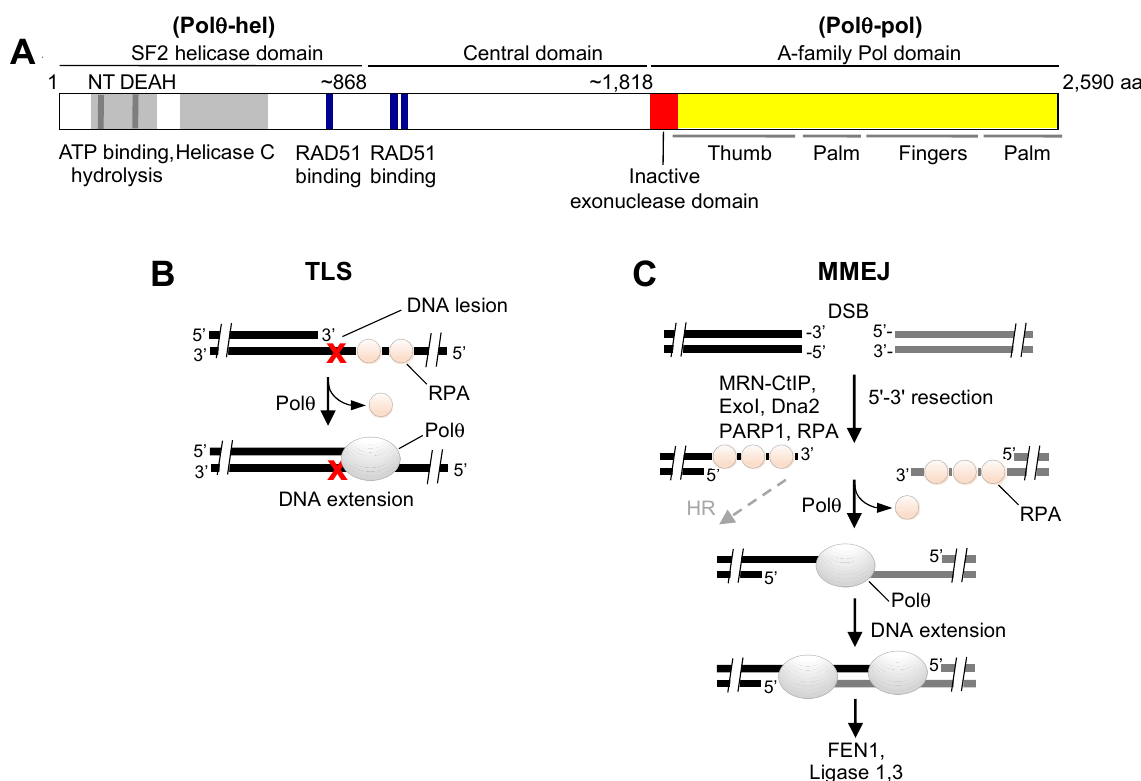
Figure 1. Overview of Pol θ structure and function in DNA repair. ( A ) Schematic of full-length Pol θ . ( B ) Pol θ performs TLS enabling cellular tolerance to DNA damaging agents, such as ultraviolet light. ( C ) Pol θ promotes MMEJ, which results in the error-prone repair of DSBs and resistance to ionizing radiation and topoisomerase inhibitors.